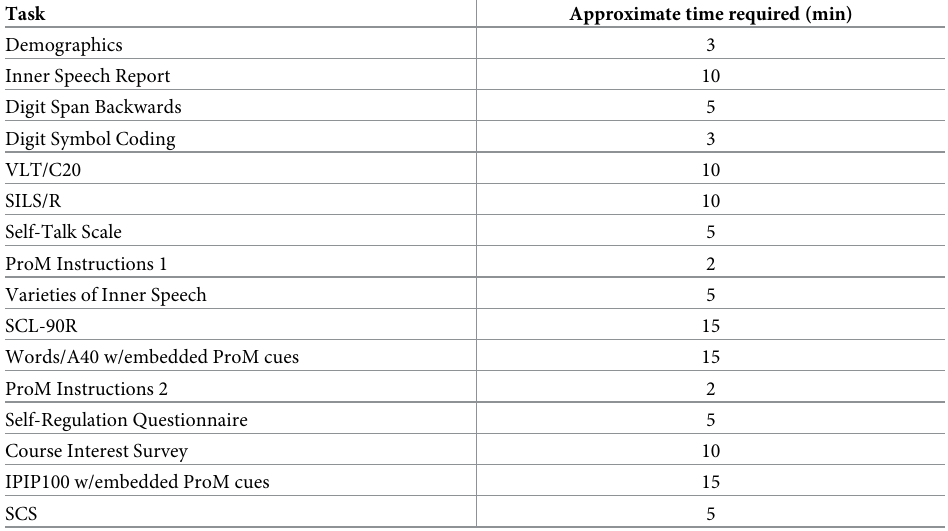
Table 1. Sequence of all instruments and tasks completed by participants, with the approximate time required to complete each